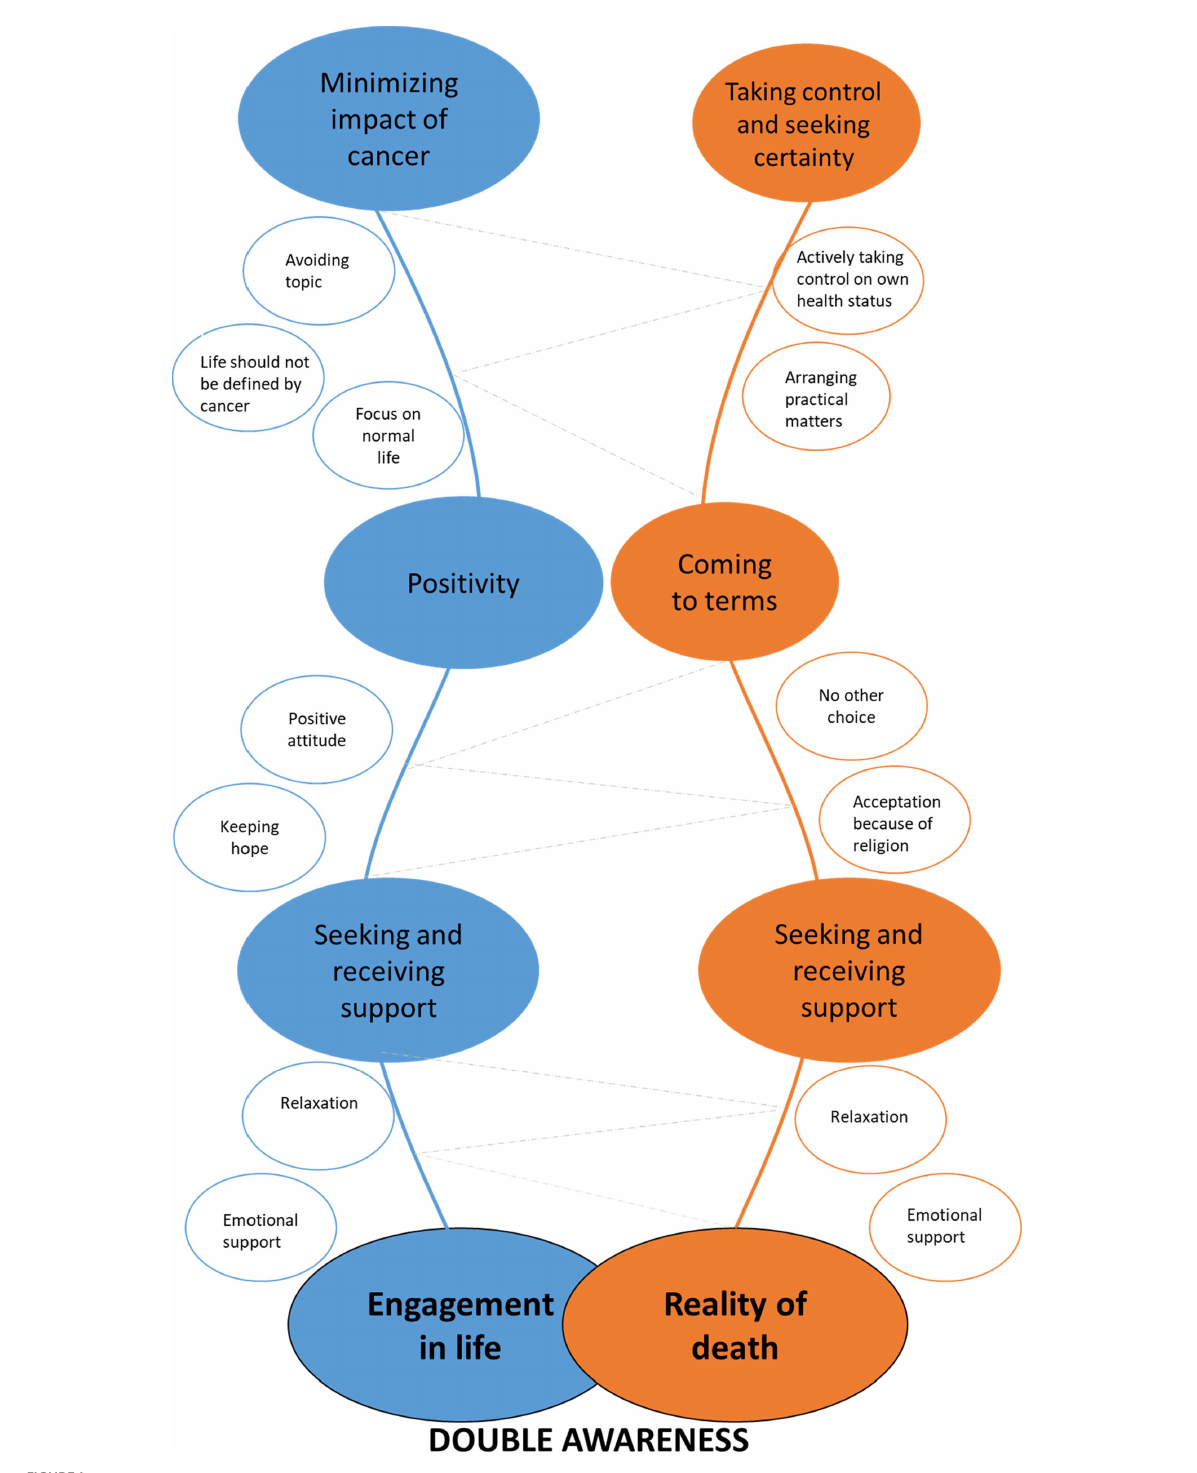
FIGURE 1 Double awareness in adolescents and young adults (AYAs) with a uncertain or poor cancer prognosis (UPCP). * Size of the colored circles represents the frequency of the reported coping strategies. (e.g.) circles of ‘minimizing impact of cancer’ and ‘seeking and receiving support’ are largest, suggesting that these coping strategies were reported the